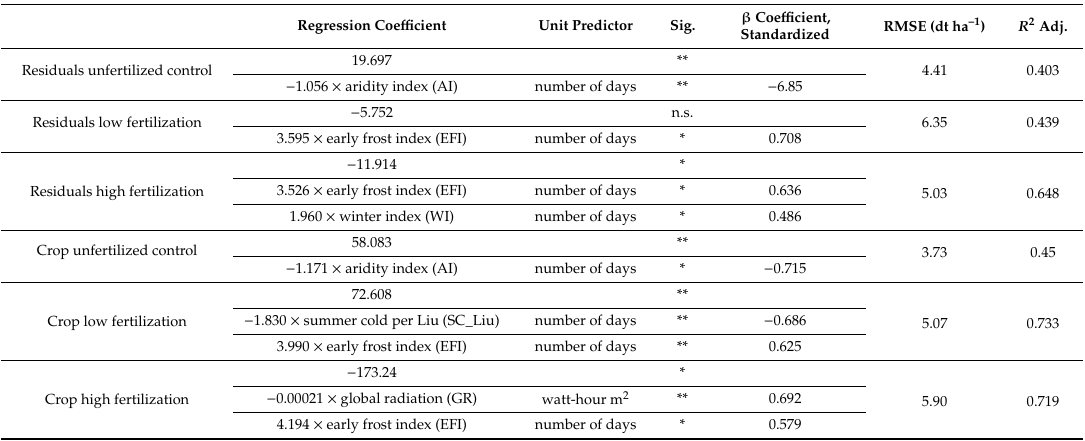
Table 7. Formulas depicting multiple linear regressions derivation of residuals and yields for di ff erent levels of fertilization with yearly climate